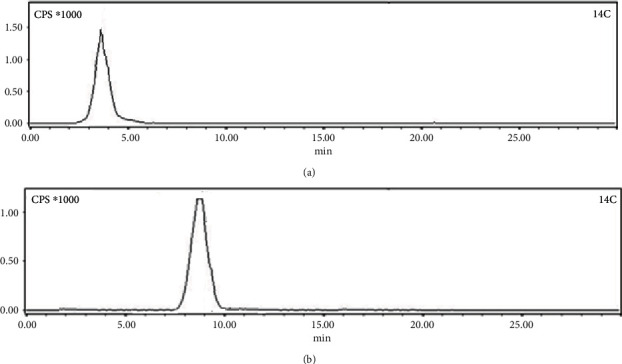
Typical HPLC profiles of (a) 177LuCl3 and (b) 177Lu-acridine.